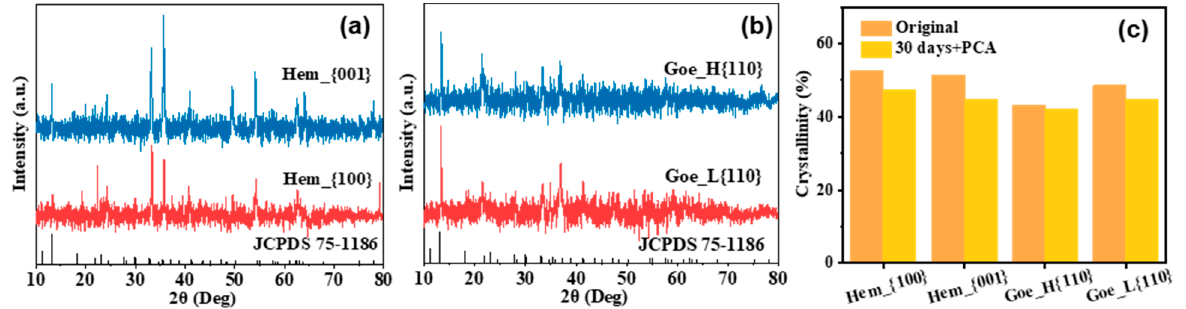
Figure 5. X-ray diffraction (XRD) patterns of phosphorus crystalline products collected 30 days after inoculation of ( a ) hematite and ( b ) goethite nanoparticles and ( c ) the crystallinity statistics. Experimental conditions: hydrophosphate-buffered (9 mM); Geobacter sulfurreducens (OD 600 ≈ 0.30); iron oxide nanocrystals (9 mM).